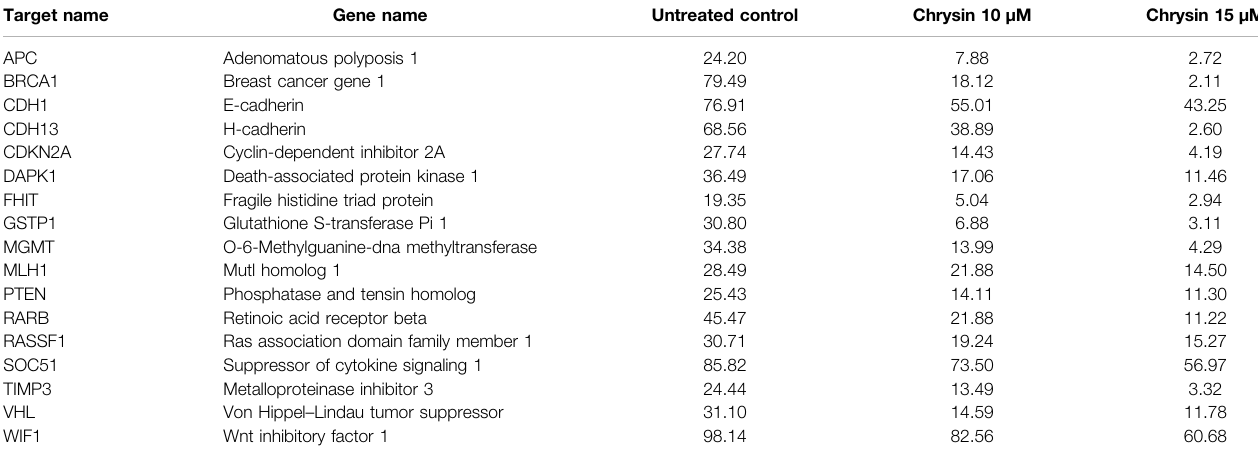
TABLE 4 | Percentage of CpG promoter methylation after chrysin treatment as compared to untreated control. The values are taken as mean of three experiments ± SD ( p ≤